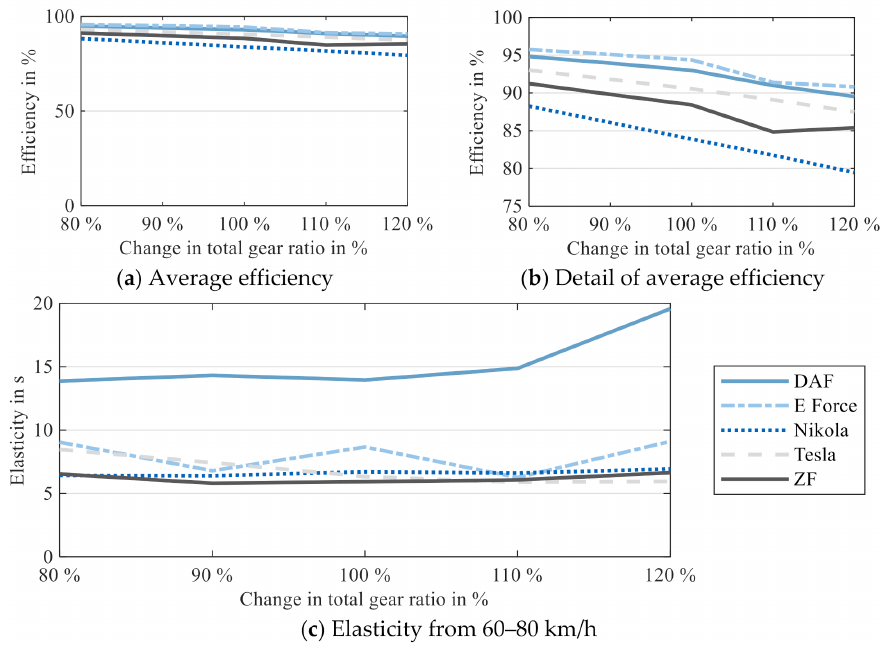
Figure 6. The sensitivity of the average electric machine efficiency ( a , b ) to the change in gear ratio shows a linear decrease in efficiency with higher gear ratios. As a measure for driving performance, the elasticity ( c ) describes the acceleration time from 60–80 km/h. Its sensitivity to the change in gear ratio shows that smaller ratios increase the elasticity except for the DAF concept. The VECTO LH cycle was used for all simulations. The spreadsheet containing the results is provided as Supplementary